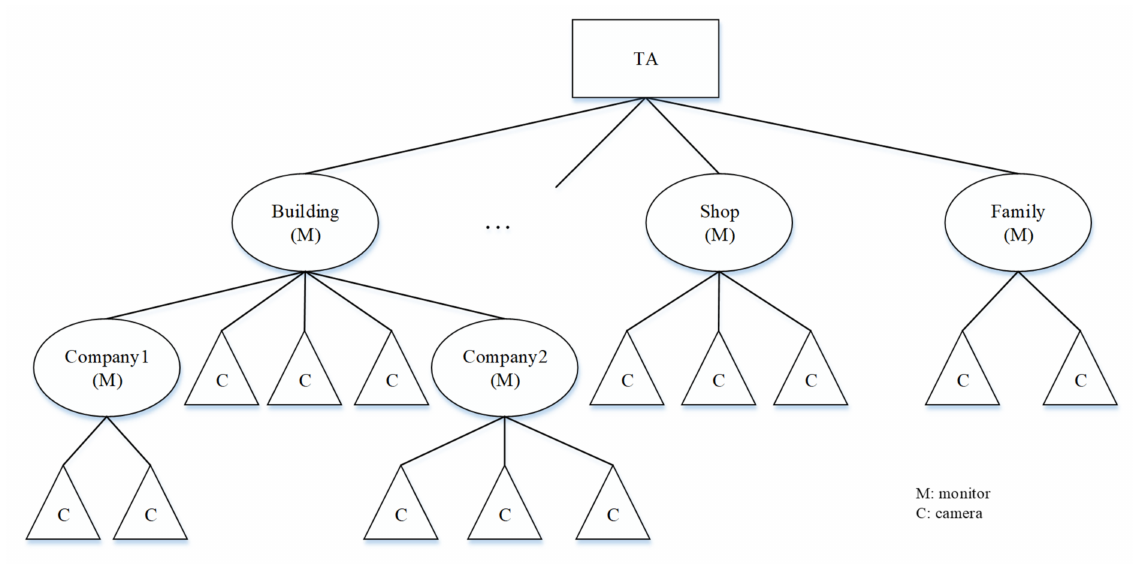
Figure 3. Hierarchical key management